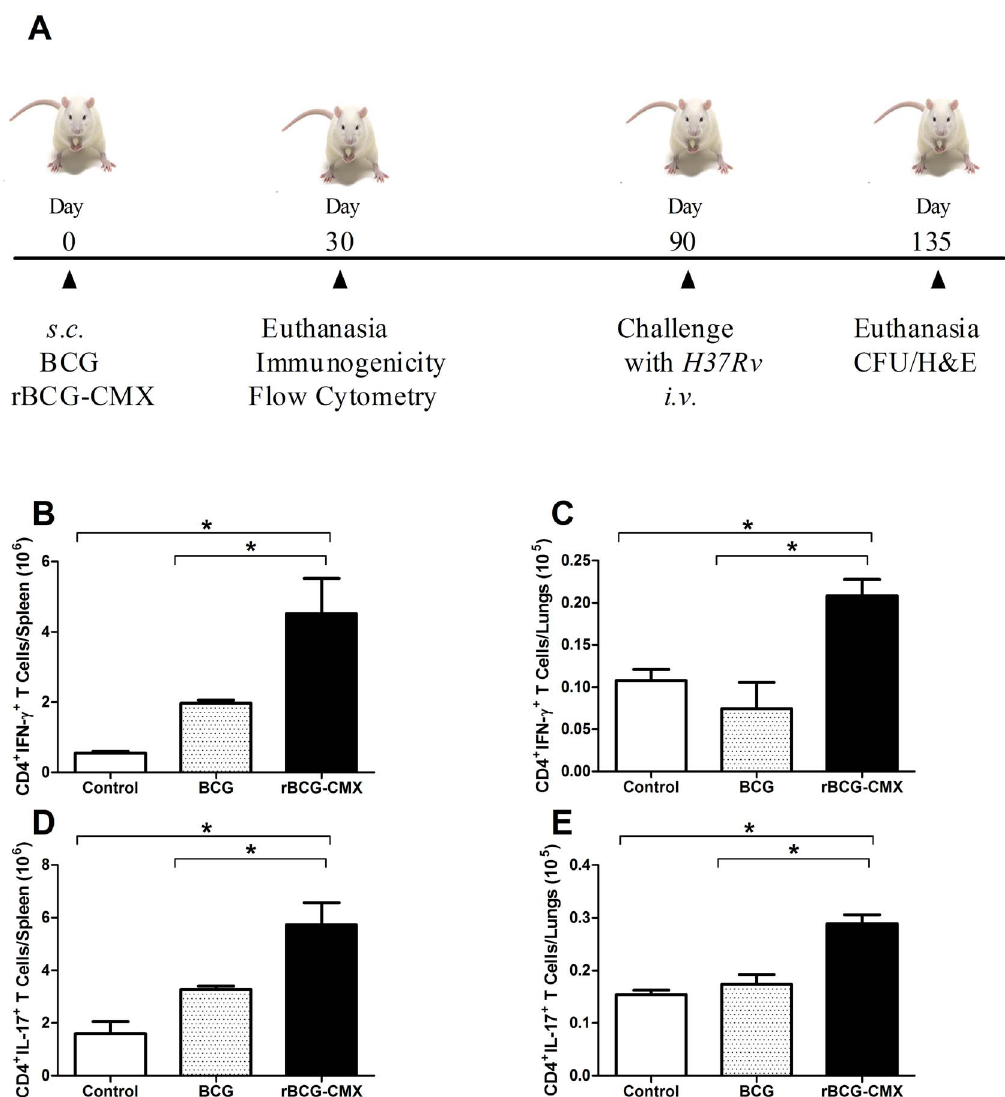
Figure 4. Immunogenicity of rBCG-CMX in BALB/c mice. (A) Experimental time line. BALB/c mice were immunized with rBCG-CMX or BCG Moreau. Thirty days later, 6 mice per group were euthanized for evaluation of vaccine-induced immunogenicity. Ninety days after immunization, mice were intravenously ( i.v. ) challenged with 10 5 CFU of H37Rv. Forty-five days after i.v. challenge, the lung bacterial load (CFU) and lesions (H&E) were assessed. (B–E) Specific cellular immune responses induced with rCMX stimulation ex vivo . Spleen (B and D) and lung (C and E) cell suspensions from vaccinated and unvaccinated (Control) mice were stimulated with rCMX. Cells positive for both CD4 and IFN- c (B and C) or CD4 and IL-17 (D and E) were determined by flow cytometry. Lymphocytes were selected based on size and granularity. Flow cytometry gates were set to analyze CD4 + T cells, and then the fluorescence of antibodies detecting IFN- c + or IL-17 + cells was recorded. These data are representative of two independent experiments (N=6, *p ,